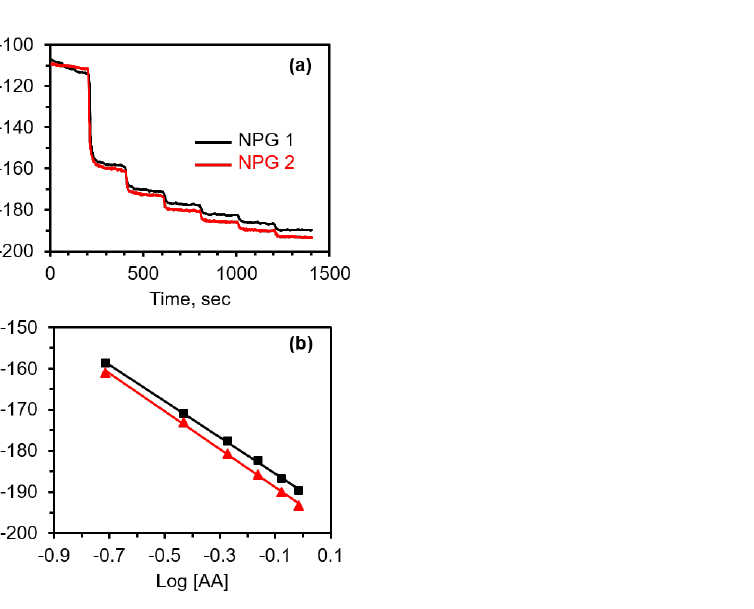
Figure 6. ( a ) OCP (E)—time traces after the addition of ascorbic acid to a buffered solution containing near-physiological concentrations of cysteine (100 µ M) and uric acid (300 µ M) at an NPG electrode. The results obtained at two different electrodes are shown (black line and red line). With each addition of AA, the OCP becomes more negative. ( b ) The logarithmic dependence of OCP on the concentration of AA (mM). Each symbol represents a different electrode.